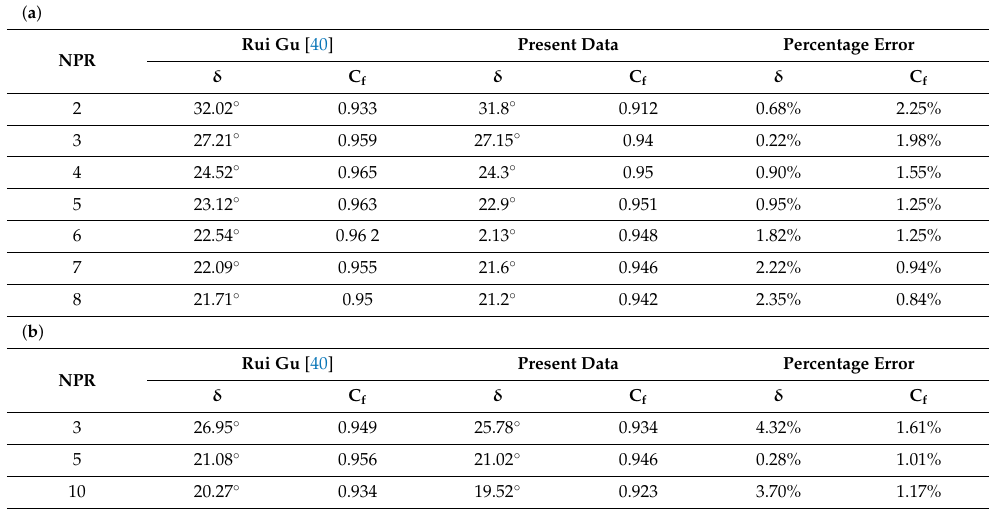
Table 3. ( a ) 2D model validation percentage error for various NPR values. ( b ) 3D model validation percentage error for NPR = 3, 5, and